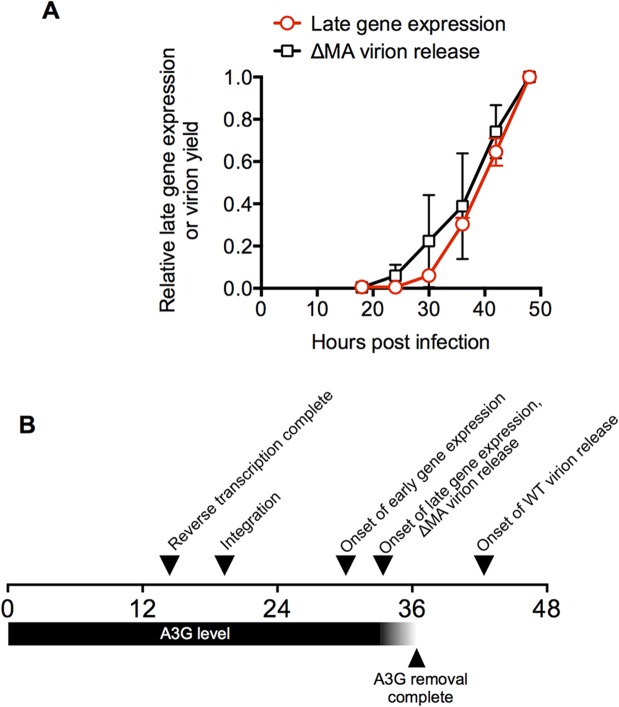
A time-line for a single cycle of HIV-1 replication in a typical cell.(A) Comparison of the dynamics of HIV-1 late gene expression and HIV-1(ΔMA) virion release in populations of cells. The mean ± sd (n = 4) of the proportion of cells expressing a late gene (Gag) reporter was calculated from the data presented as four individual curves in Fig 1C and plotted along with the level of virion release exhibited by HIV-1(ΔMA) infected cells (same data as in Fig 3C). (B) A time line for HIV infection in a typical MT4 cell. The horizontal scale indicates the time (in hours) after exposure to virus. Times for the completion of reverse transcription and integration, early and late gene expression are depicted as the 50% values for cell populations, as described in Fig 1. The timing for the completion of A3G removal is depicted relative to the detection of late gene expression, as determined in Fig 5. The interval between late gene expression and onset of WT virion release is depicted as the interval between initial detection of late gene or Gag expression in cells (which occurred at approximately the same time) and the initial detection of virion-associated CA protein in the culture supernatant.